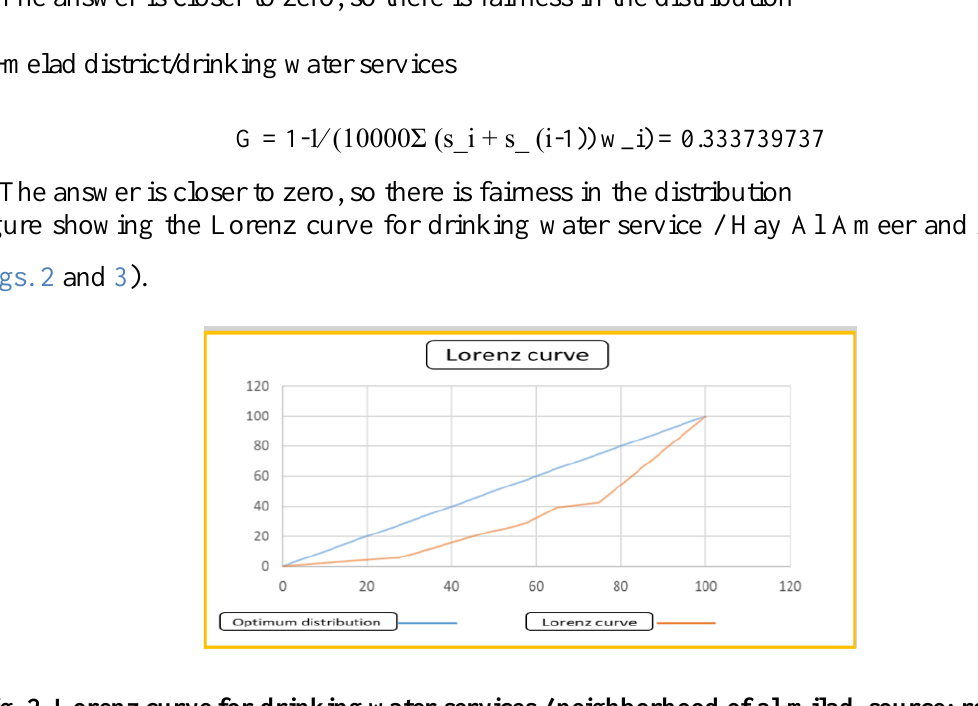
Fig. 2. Lorenz curve for drinking water services / neighborhood of al-milad, source: researcher based on previous